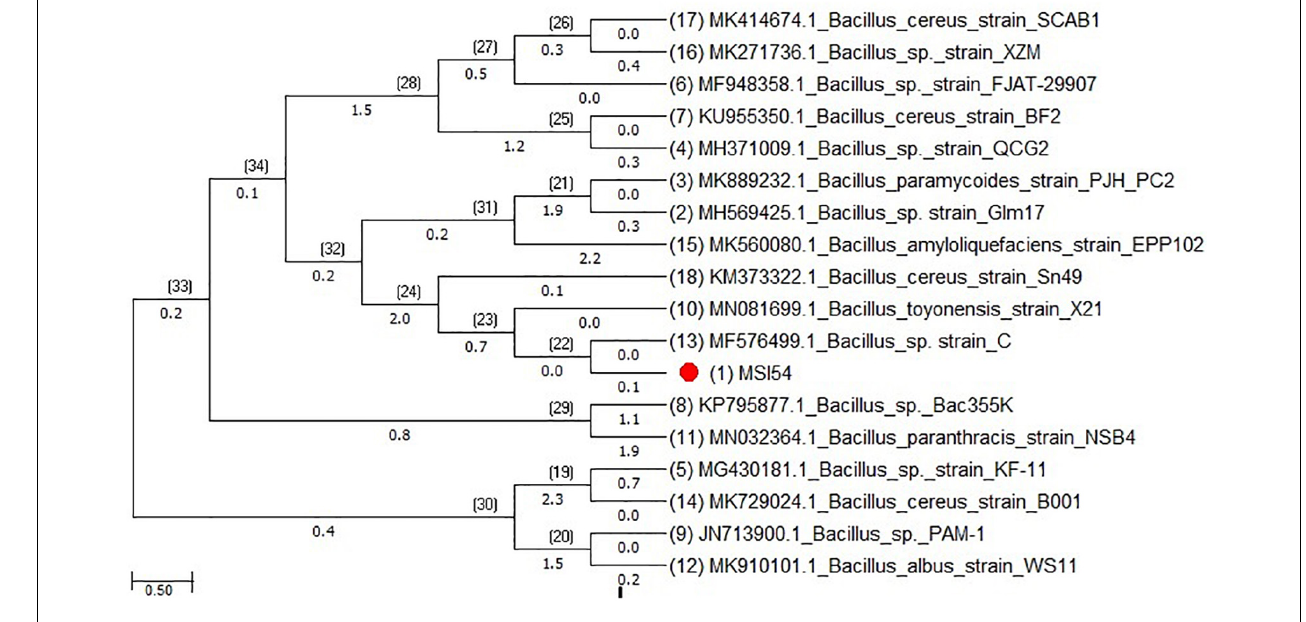
FIGURE 1 | Phylogenetic tree of MSI 54 constructed using the neighbor joining (NJ) method showing representatives of Bacillus